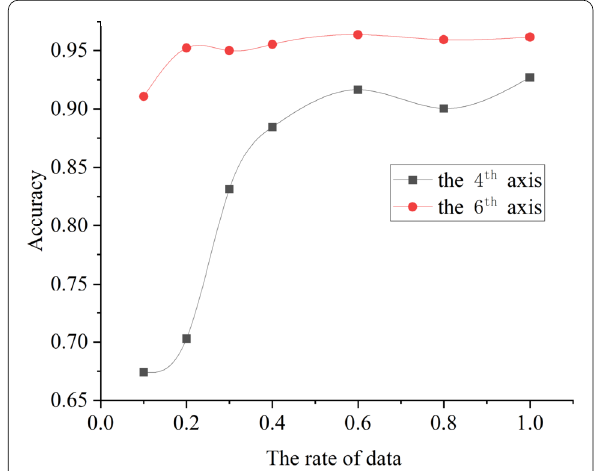
Figure 7 Comparison diagram of fault diagnosis results of the 4th axis before transfer